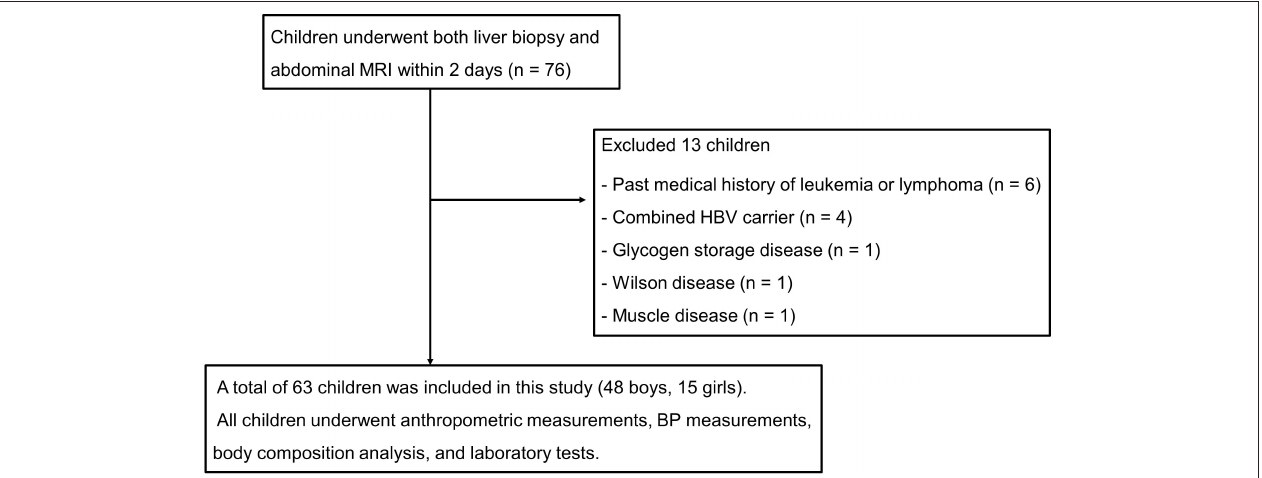
FIGURE 1 | Flow diagram showing the selection of subjects. A sample size of at least 63 was estimated to have a type I error rate of 0.05, with a power of 80%. The present study included 63 children and adolescents with liver biopsy-proven non-alcoholic fatty liver disease (NAFLD) who underwent both liver biopsy and abdominal magnetic resonance imaging (MRI) performed within 2 days from March 2014 to February 2020. NAFLD was diagnosed as the presence of steatosis in ≥ 5% of hepatocytes in the absence of other liver diseases. Secondary etiologies of hepatic steatosis, systemic diseases, and pancreatic diseases were excluded. HBV, hepatitis B virus; BP, blood